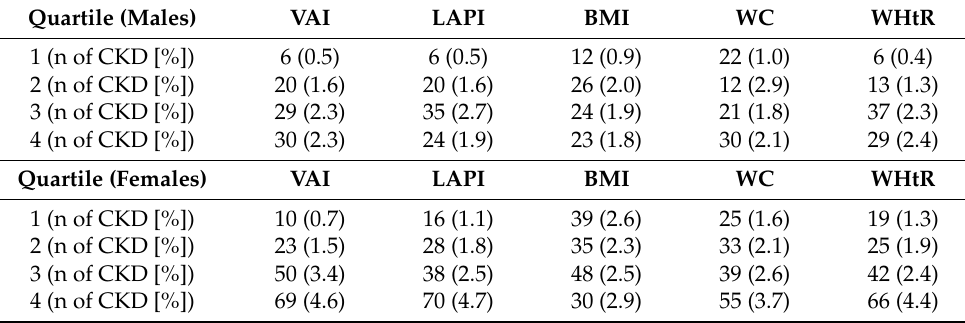
Table 2. Prevalence of CKD in quartiles of VAI, LAPI, BMI, WC and